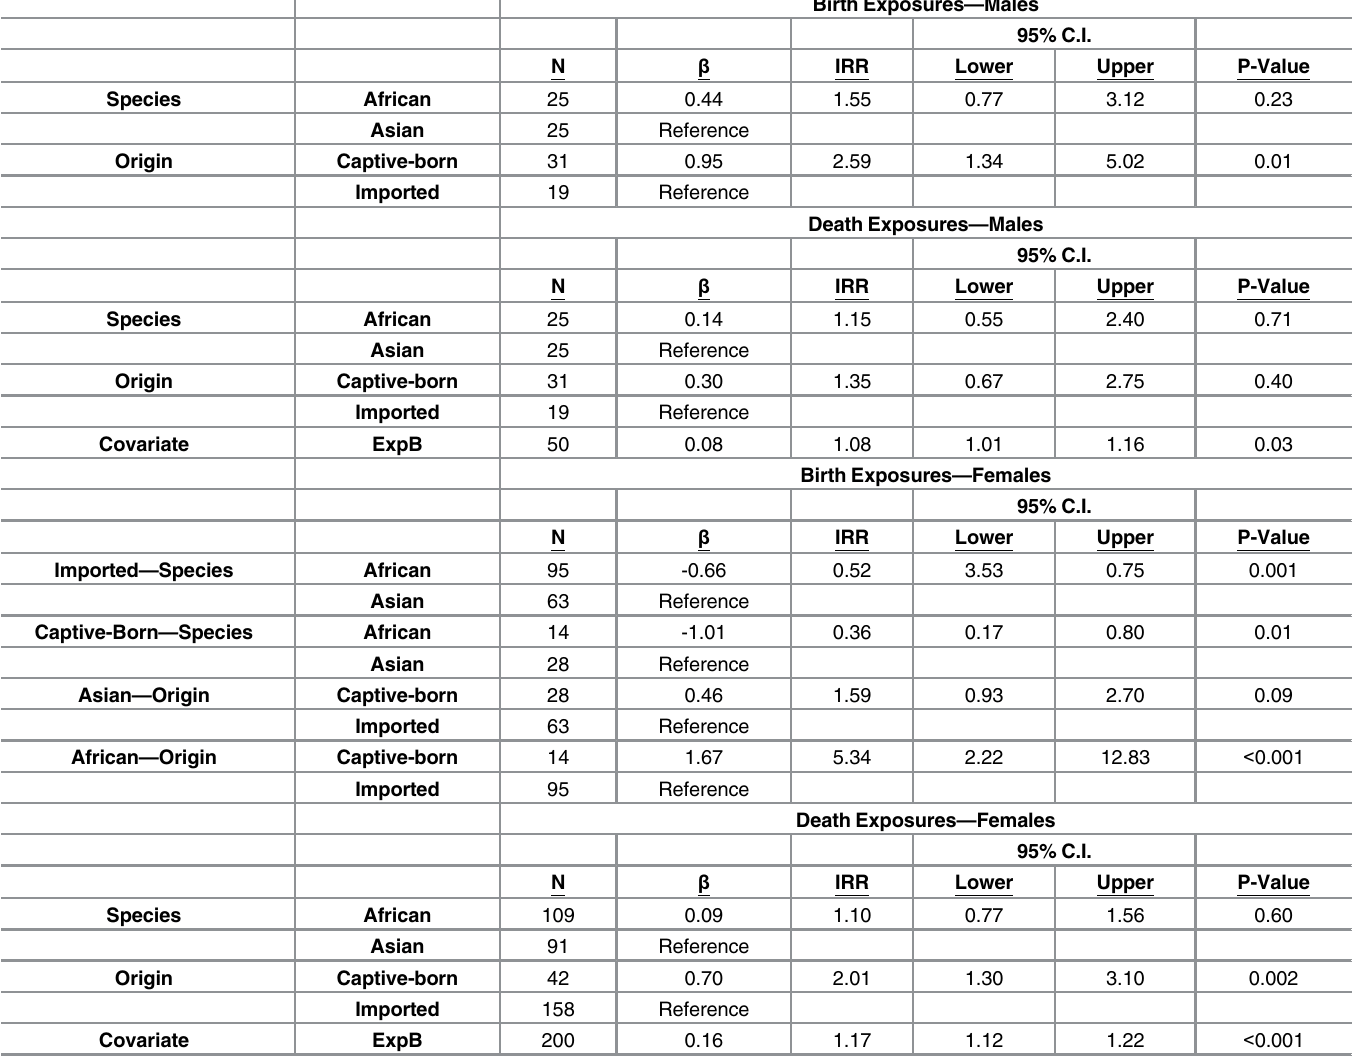
Table 6. Summary of incident rate ratios (IRR) relative to time using Poisson regression models, including 95% confidence intervals for IRR. p < 0.05. IRR = estimated rate of event